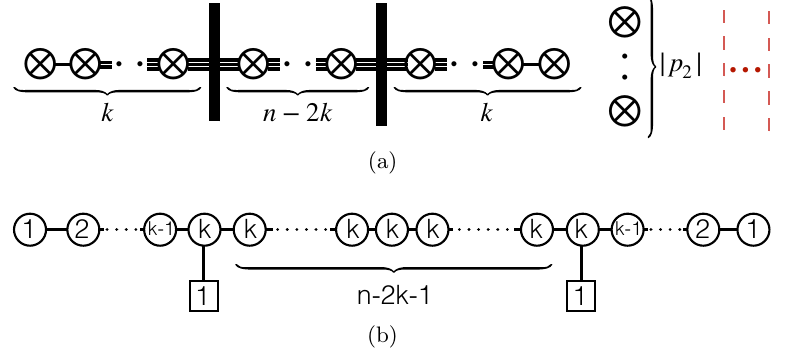
Figure 19 . (a) The j p 2 j NS5-branes and the D7-branes on the right are decoupled from the rest of the system. (b) The SQM quiver realized on the D1-branes in the brane con(cid:12)guration in (cid:12)gure 19(a). There are ( n (cid:0) 2 k + 1) U( k ) gauge nodes. There is no Fermi